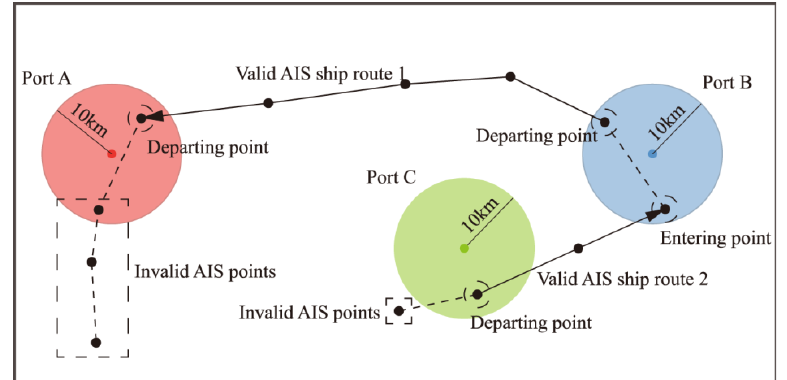
Figure 3. Schematic diagram of single-ship voyage division based on inbound and outbound identification.